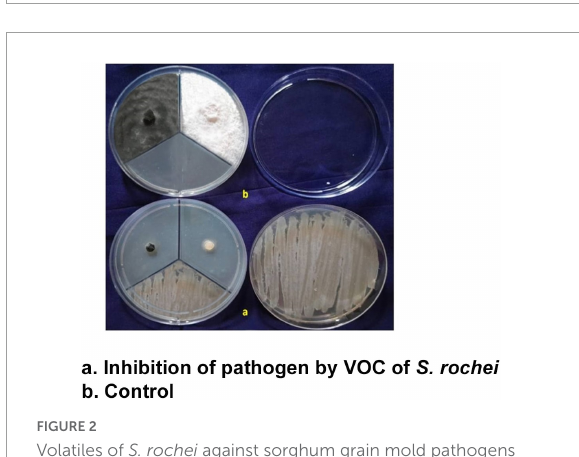
FIGURE1 Antagonistic effect of S. rochei against grain mold pathogens of Sorghum. (A) Dual culture technique. (B) Interaction of pathogen with S. rochei . Red arrows indicate effect of S. rochei on mycelia of pathogen.